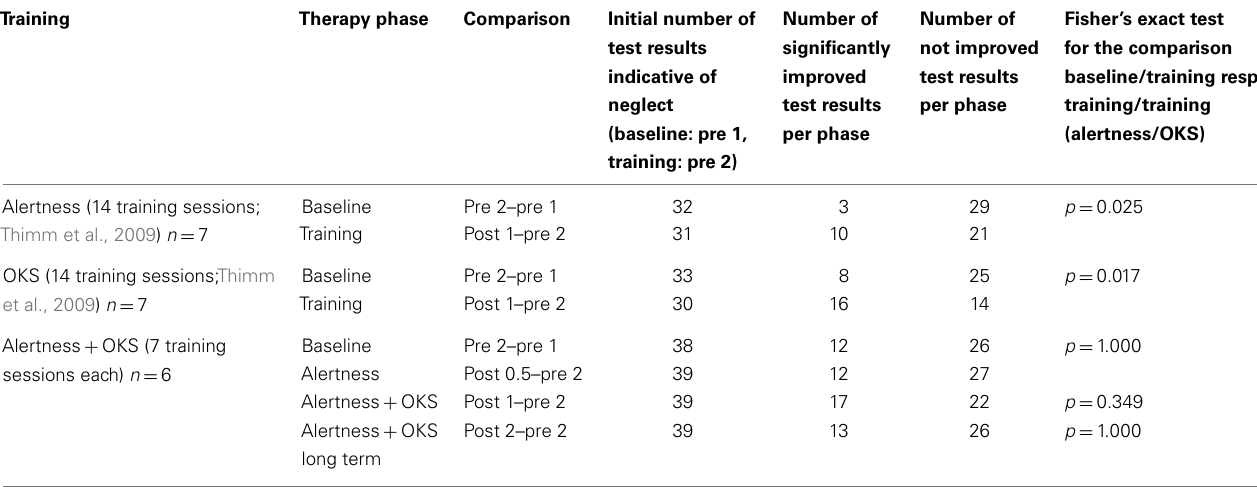
Table 4 | Number of improved or unchanged test results after the different training periods (see Figure 1) and results of Fisher’s exact test for the current and for the preceding